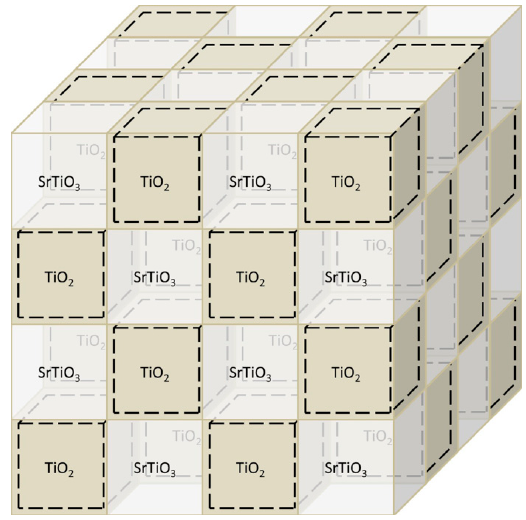
− SrTiO 2 3 biphase